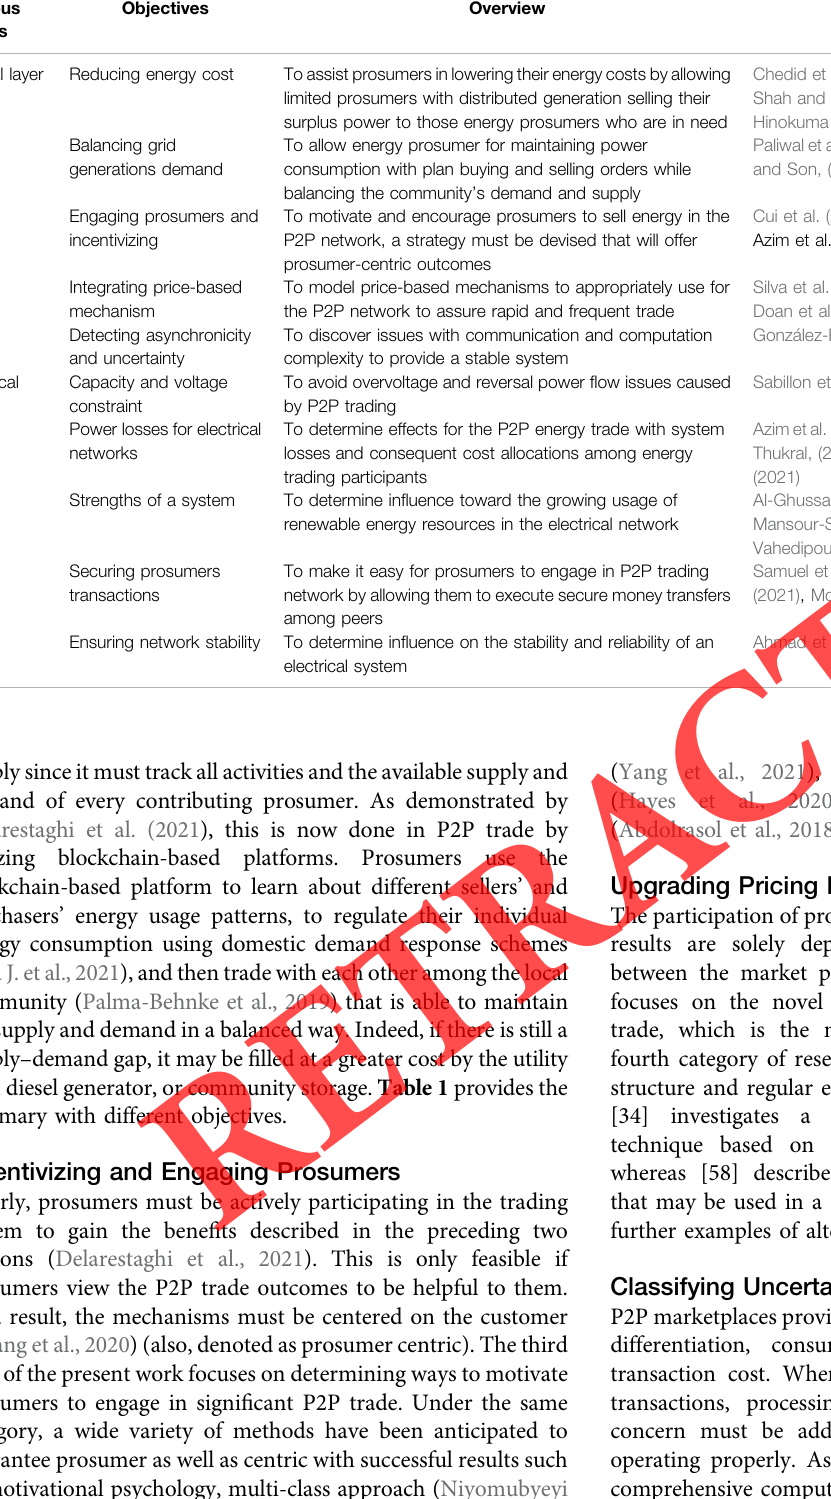
TABLE 1 | A summary of several types of research aimed at achieving different types of objectives for virtual – physical layer platforms Various